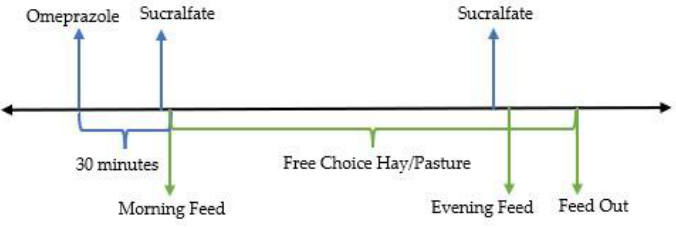
Figure 5. Proposed timing of omeprazole and sucralfate administration and feeding.